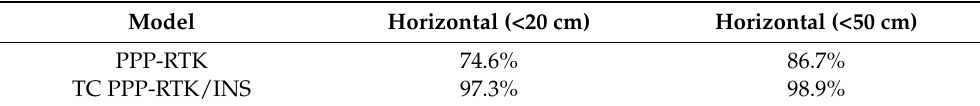
Table 4. Positioning availability in the horizontal component of PPP-RTK and TC PPP-RTK/INS in experiment A.